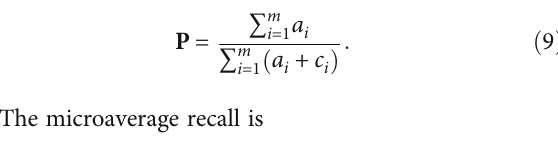
Table 2: Whether the n queries belong to the division of navigation